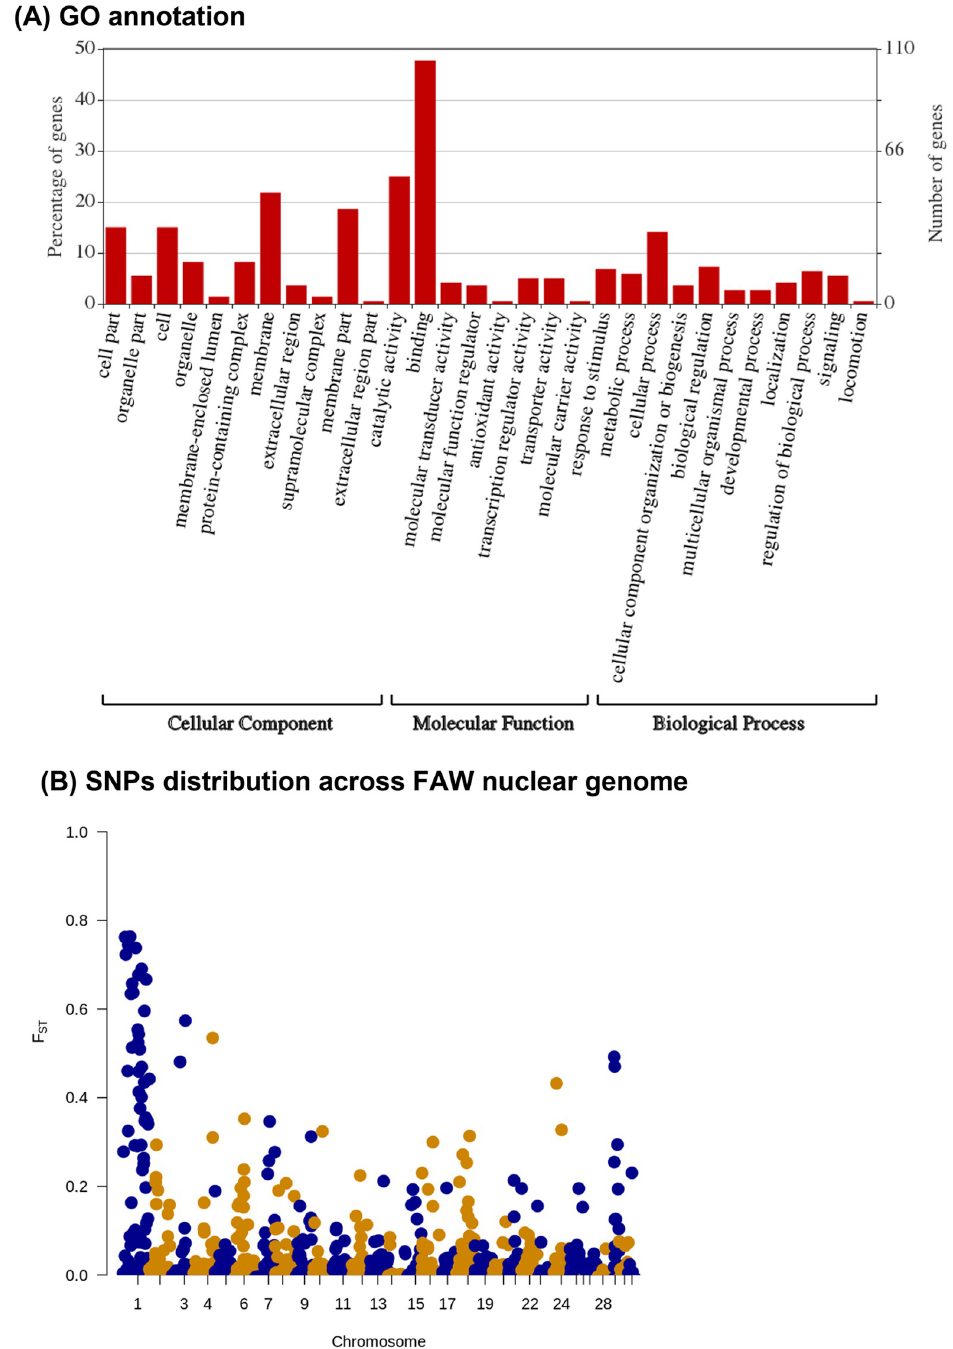
Fig 6. Outlier SNPs under positive selection using Pcadapt, FstHet, and FLK. (A) GO categories of putative loci under selection generated from WEGO. The results are presented in three main categories: biological process, cellular component, and molecular function. The left y-axis indicates the percentage of a specific category of genes in the main category. The right y-axis indicates the number of genes in each category. (B) Manhattan plot of F ST analysis comparing C-strain and R-strain against the position of SNPs on each of the 31 chromosomes. Chromosome 1 corresponds to the sex chromosome Z. Each SNP is represented by a dot. Chromosomes are represented by blue (odd) and orange